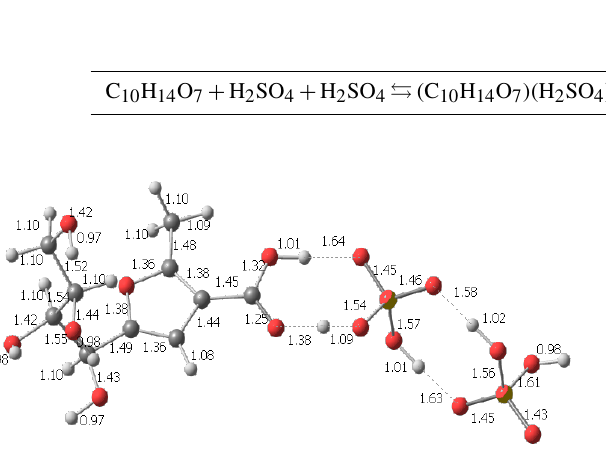
Figure 1. The equilibrium geometry of the most stable isomers of the heteromolecular trimer composed of (C 10 H 14 O 7 ) (H 2 SO 4 ) 2 ob- tained at the PW91PW91/6-311 ++ G(3df,3pd) level of theory. The bonding lengths are in Ångstroms.